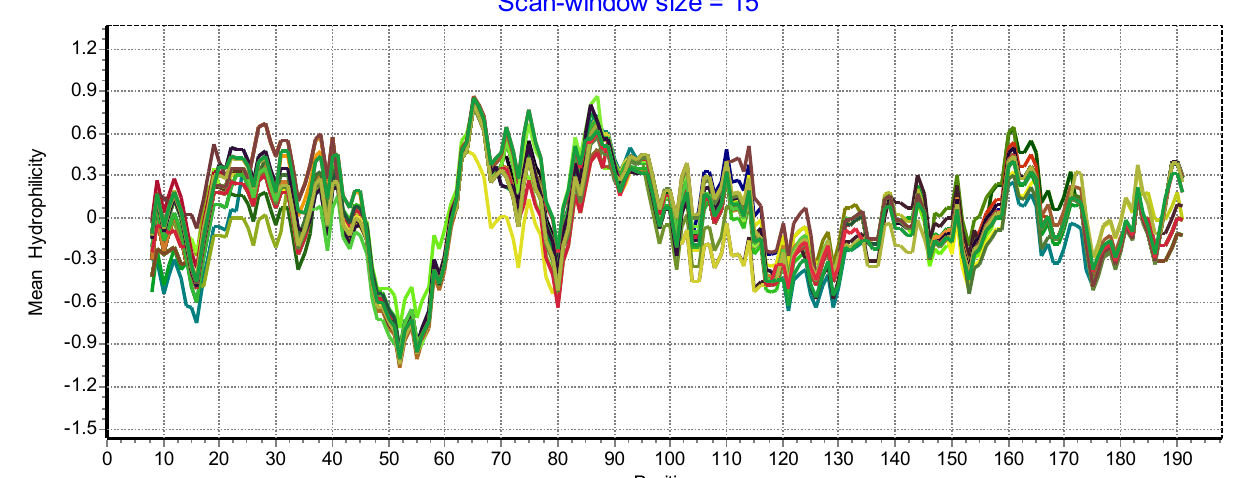
Figure 2. Hydrophilicity profile for the capsid protein of Grapevine leafroll-associated virus 2 (GLRaV-2). Sequences from phy - logroups in Figure 1 are shown. The average antigenicity values are plotted versus position along the amino acid sequence. The x-axis contains 198 increments, each representing an amino acid. The y-axis represents the range of hydrophilicity values (from 3 to -3.4) (Hopp and Woods,